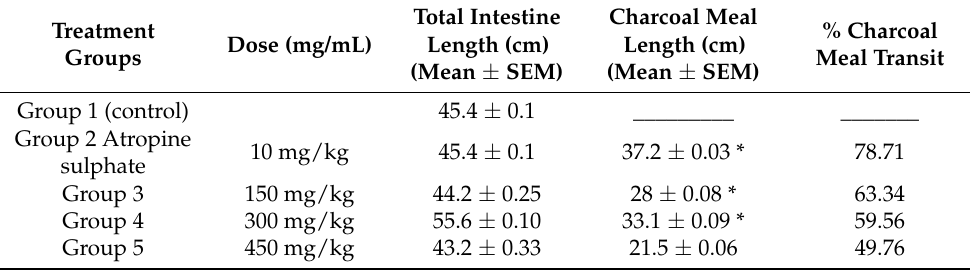
Table 4. Antispasmodic potential in methanolic extracts of different doses. All treatments consist of 5 groups. Each group has 3 replicates. Each group of mice was treated with a different methanolic extract/dose. The expression of value was mean ± SEM based. The mean difference was considered statistically significant at the 0.05 level. Significance indicated (* p <